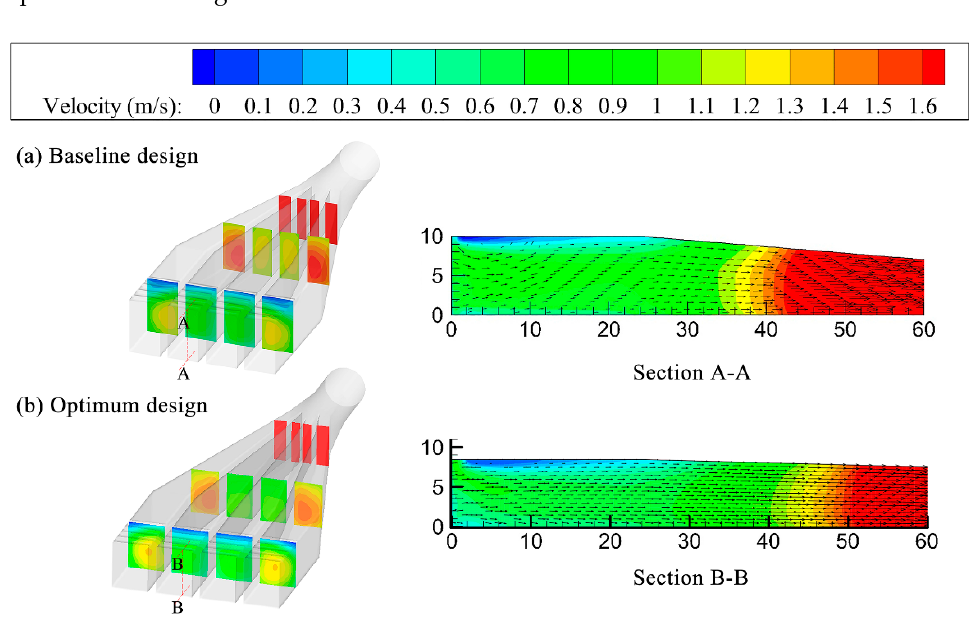
Figure 13. The comparison of inflow velocity distribution between the baseline and optimum design.